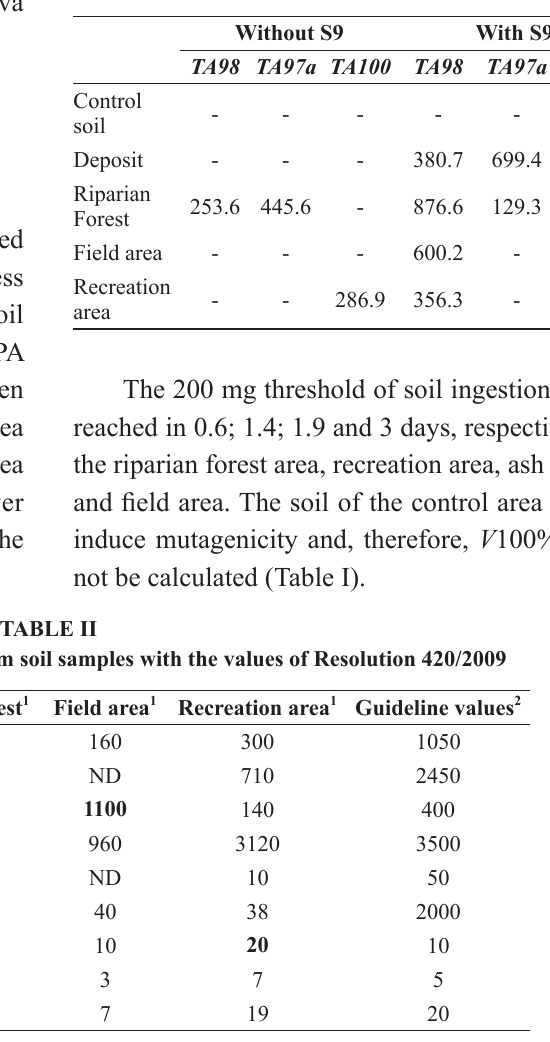
Soil volume necessary for the induction of